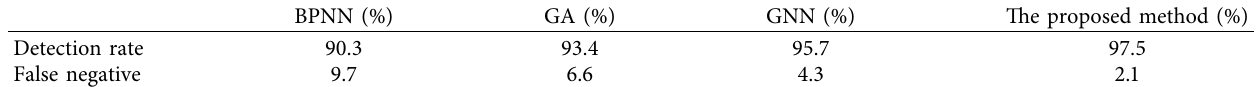
Table 5: Efectiveness comparison with other detection